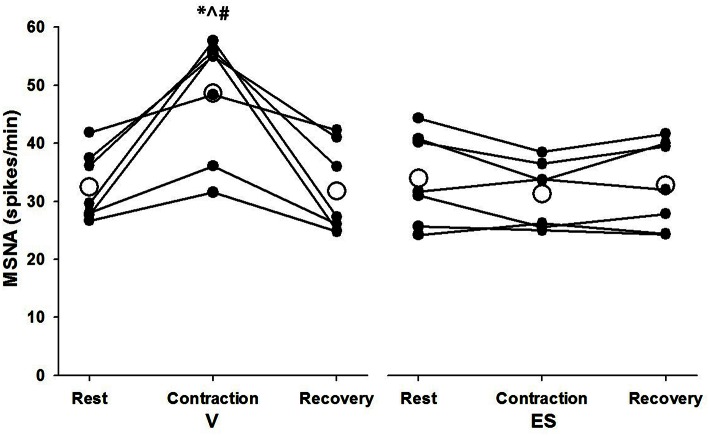
MSNA spike frequency during 1-min periods of rest, contraction, and recovery for voluntary and electrically-evoked contractions. Mean values are shown as open circles and individual values are shown as closed circles. *Significant main effect of time (P < 0.01). #Significant main effect of condition (P = 0.05). ∧Significant interaction of time and condition (P < 0.01).